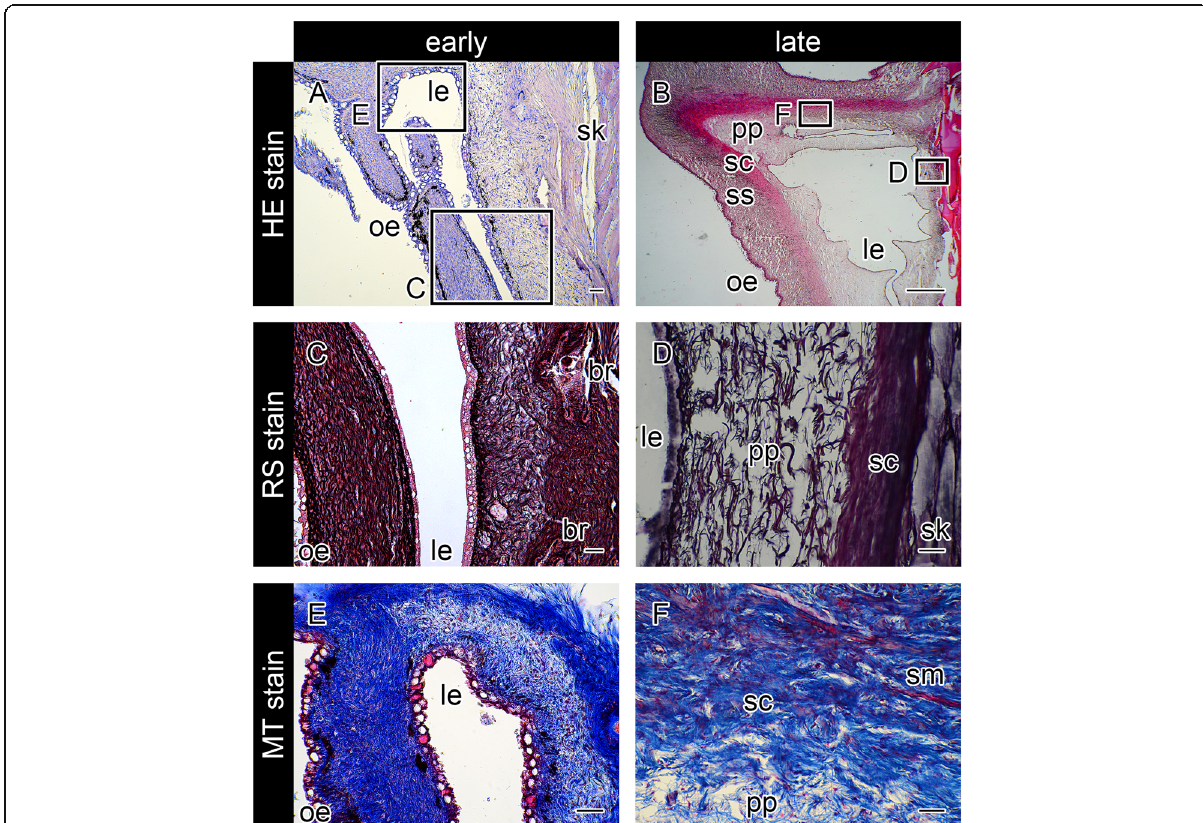
Fig. 6 Sagittal sections of the seahorse brood pouch. Sections of the early stage just after a baggy structure is formed ( a , c , e ), and in the late stage ( b , d , f ), after hematoxylin and eosin (HE) staining ( a , b ), reticulin silver (RS) staining ( c , d ), and Masson ’ s trichrome (MT) staining ( e , f ). The ventral side is to the left and the dorsal side is to the right. The lettered boxes in a and b indicate the corresponding sites of high magnification views shown in c-f . Scale bars: a , c – f = 40 μ m; b = 1 mm. br, body ring; le, luminal epithelium; oe, outer epithelium; pp, pseudoplacenta; sc, stratum compactum; sk, skeletal muscle; sm, smooth muscle; ss, stratum